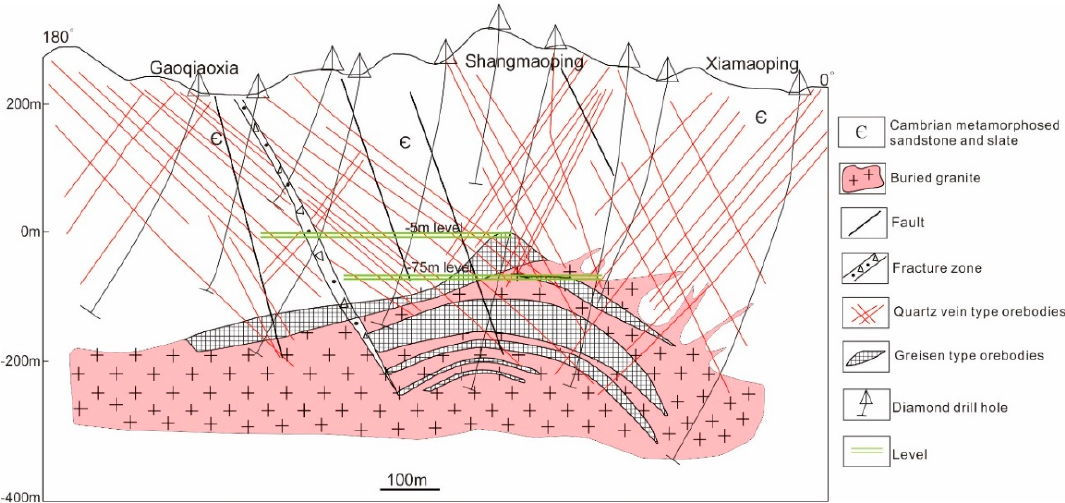
Figure 3. A geologic section in the Maoping tungsten deposit. See line 300 in Figure 2 (modified from